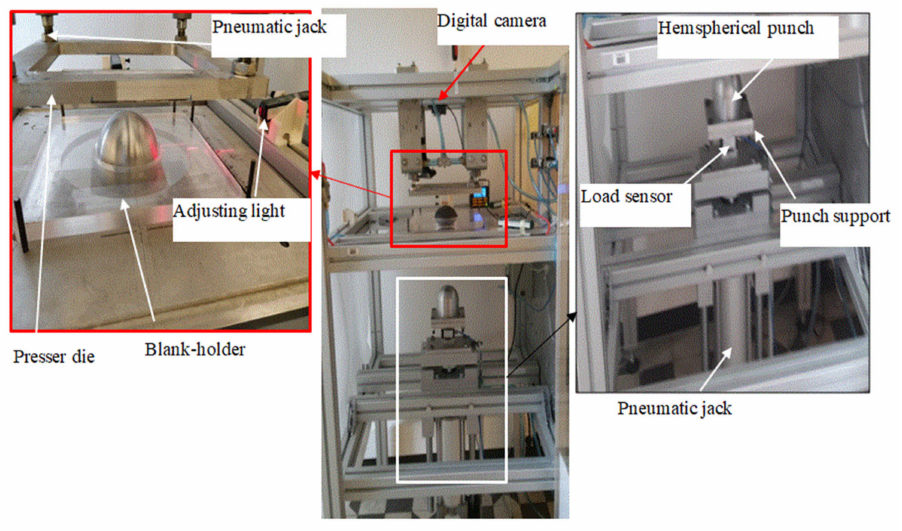
Figure 4. Formability testing machine with its hemispherical